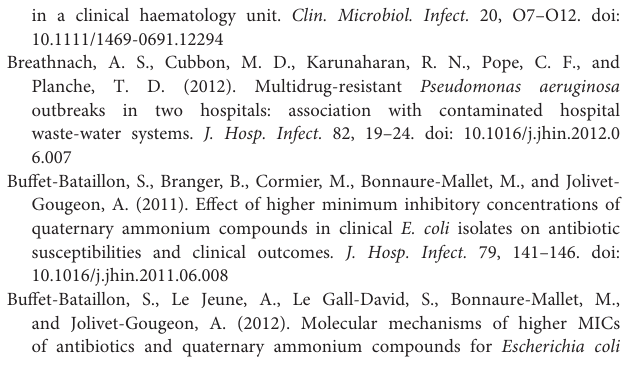
Figure S1 | Illustration of the diversity of the PFGE profiles among E. cloacae isolates. Table S1 | MICs of QACs for clinical E. cloacae strains recovered in our hospital. a AmpC ++ , overexpressed AmpC ; ESBL, extended-spectrum β -lactamase ; WT, wild